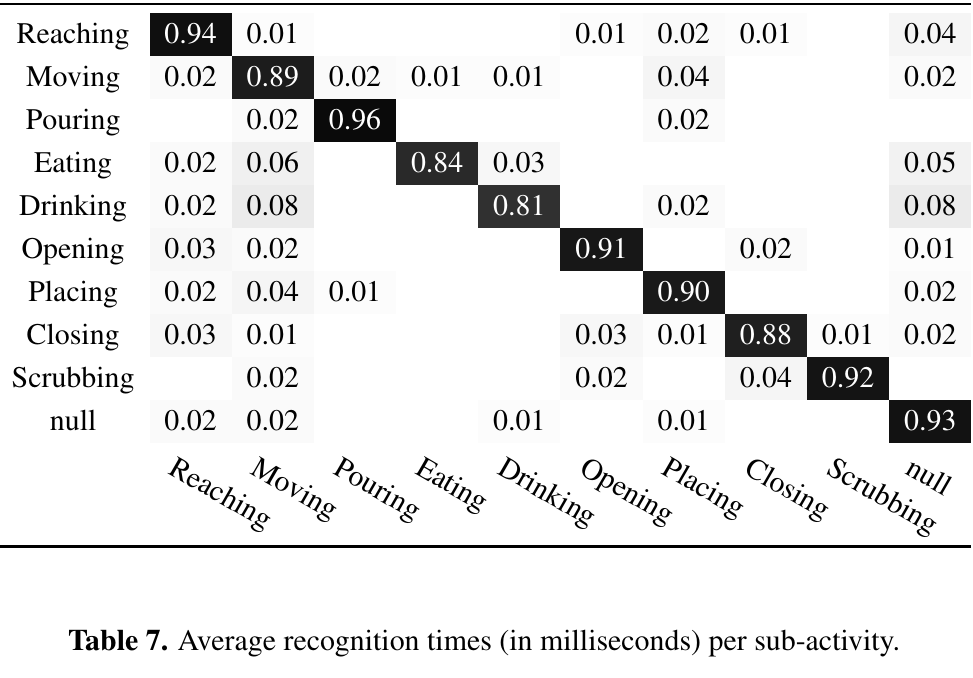
Table 6. Confusion matrix for sub-activity labeling.